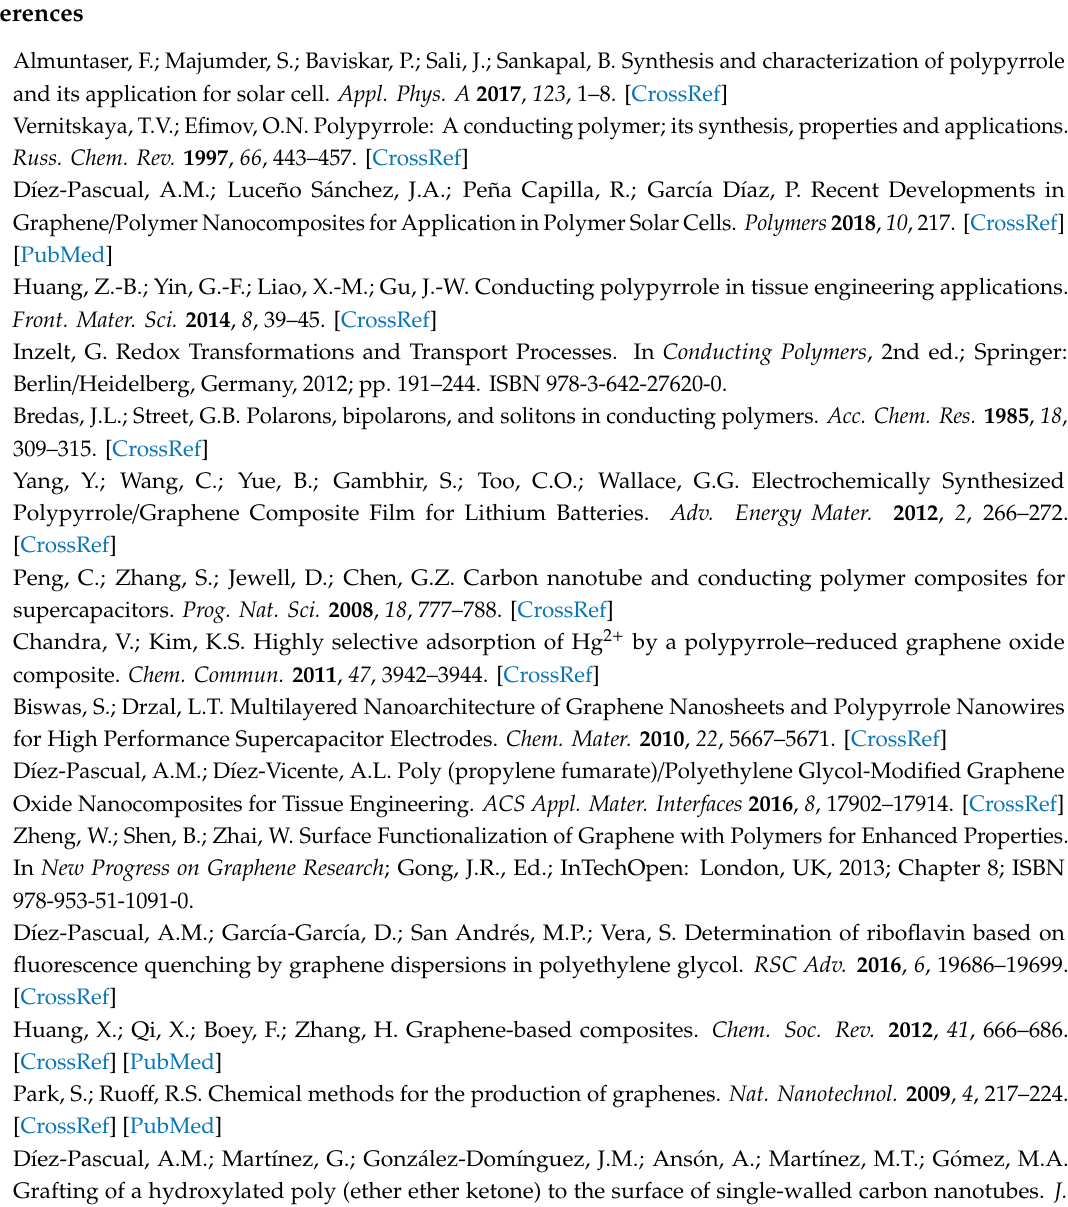
Table S1: TGA, surface area and sheet resistance data of GO, HDI-GO, PPy-COOH, and the grafted